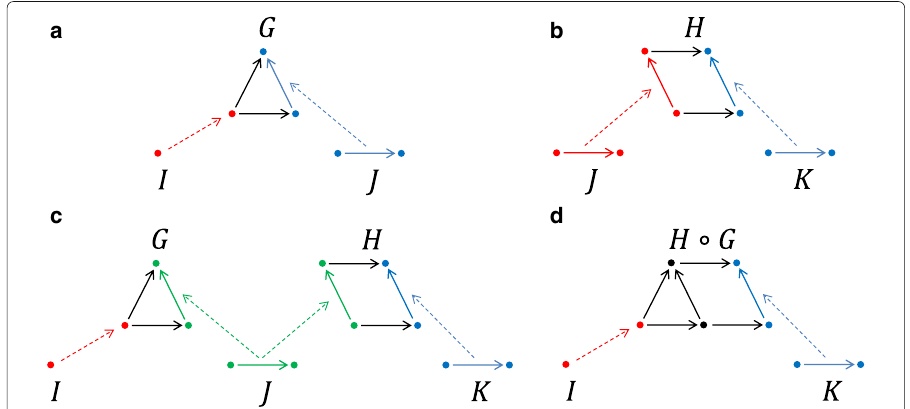
Fig. 1 An example of composition ( c , d ) of cospans ( a , b ) in the category of directed networks D . See the main text for